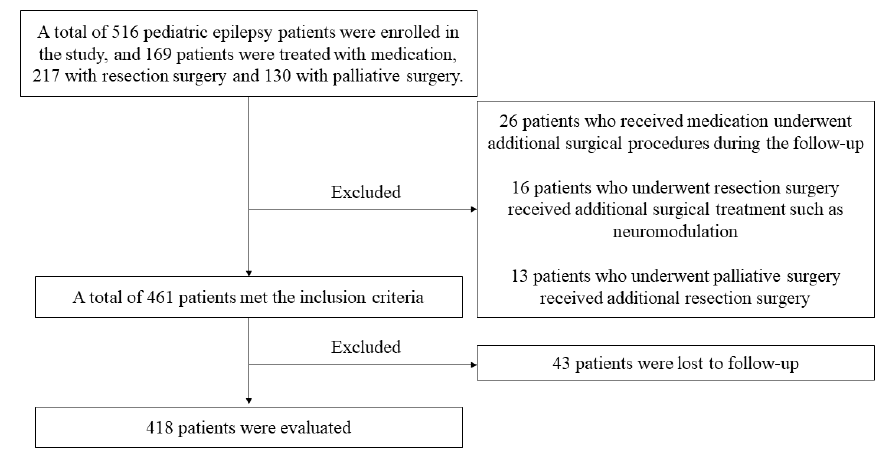
Figure 1. Flowchart describing the procedures and exclusion and inclusion criteria of this study.